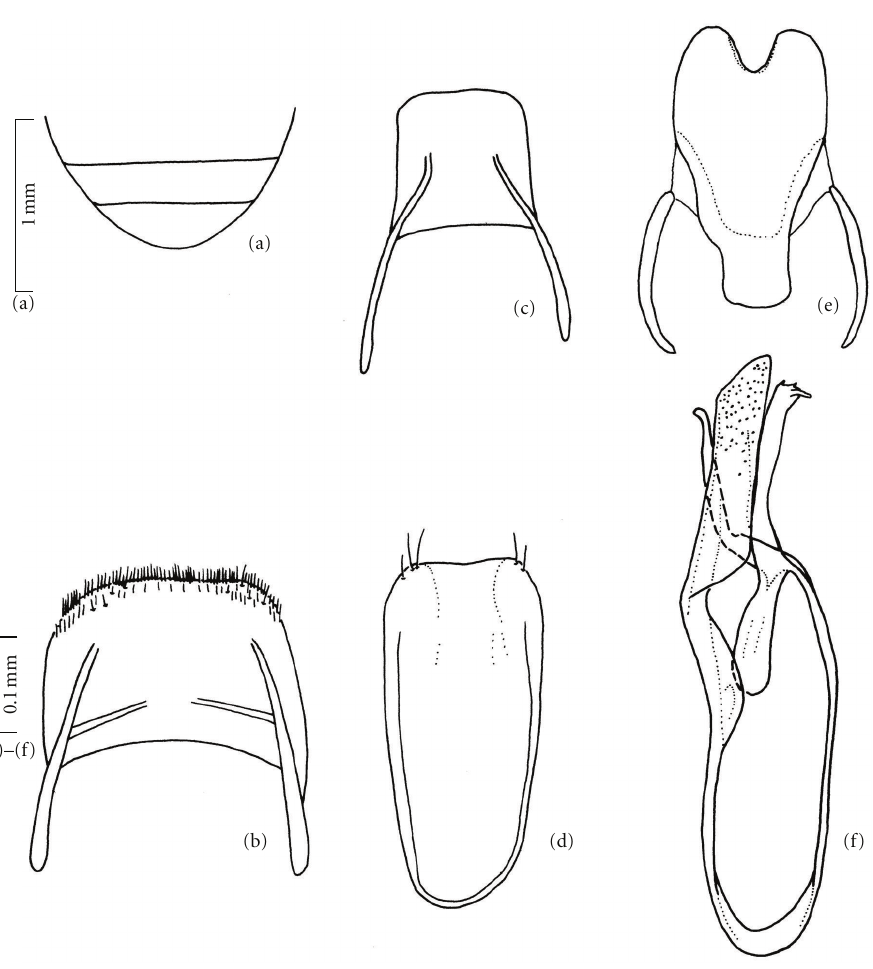
Figure 10: Hydrocyphon deformis sp.n., holotype, male. (a) Sternites V–VII; (b) tergite VIII; (c) tergite IX; (d) sternite IX; (e) tegmen; (f) penis.